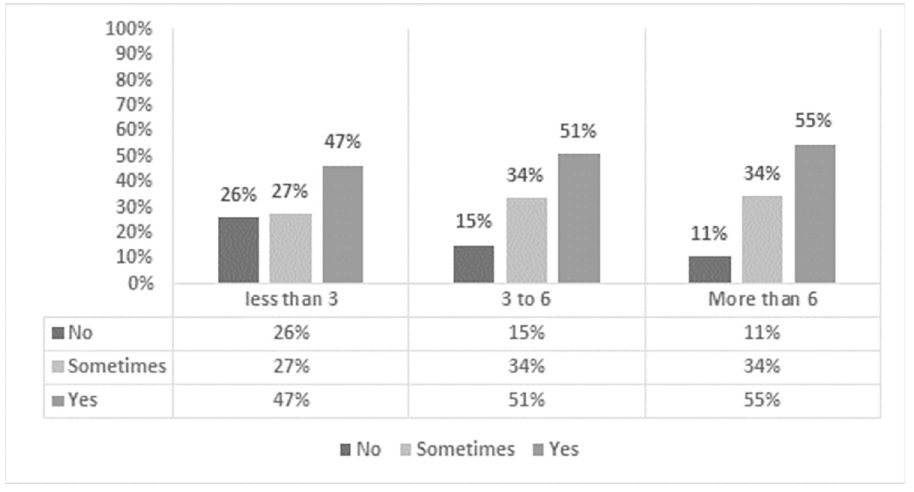
Fig 1. Number of working hours and frequency of physical issues.